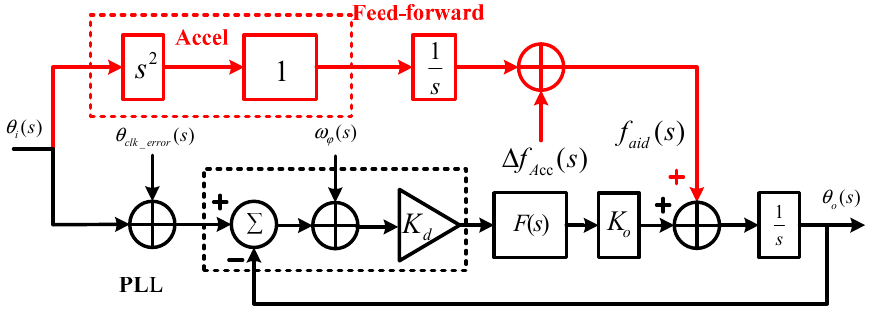
Figure 6. Error transfer model of microelectromechanical systems (MEMS) accelerometer-aided PLLs.